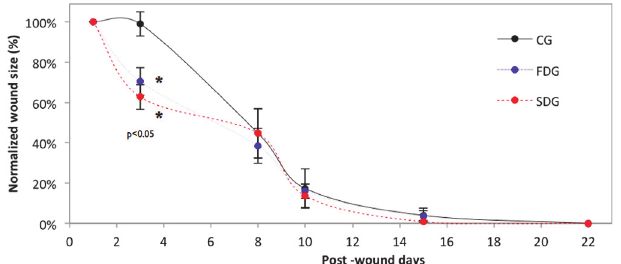
Fig 2. Percentage of normalized wound closure throughout experiment demonstrating the effect of laser therapy in the early tissue repair process. (mean ± SEM, p < 0.05)